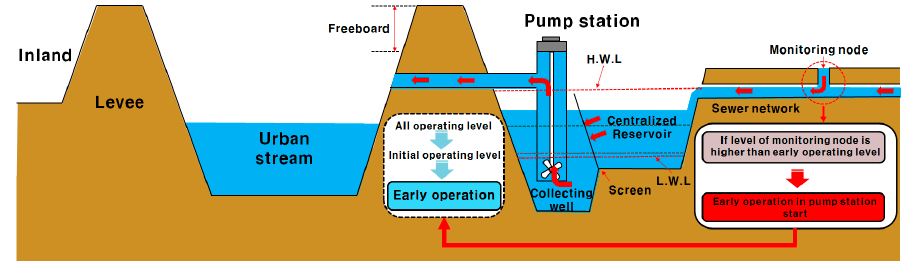
Figure 5. New operation method for a pump station with a centralized reservoir.